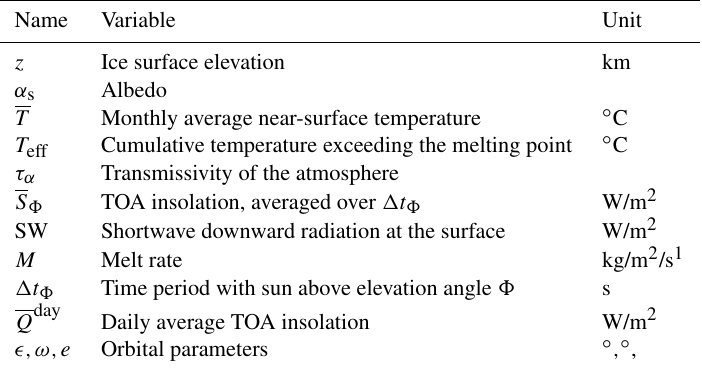
Table A1. Variables used in dEBM-simple.